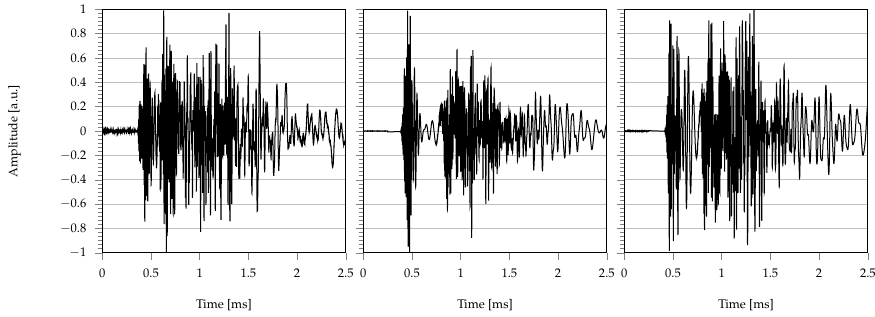
Figure 5. Example of synthetic signals generated with the ray–tracing